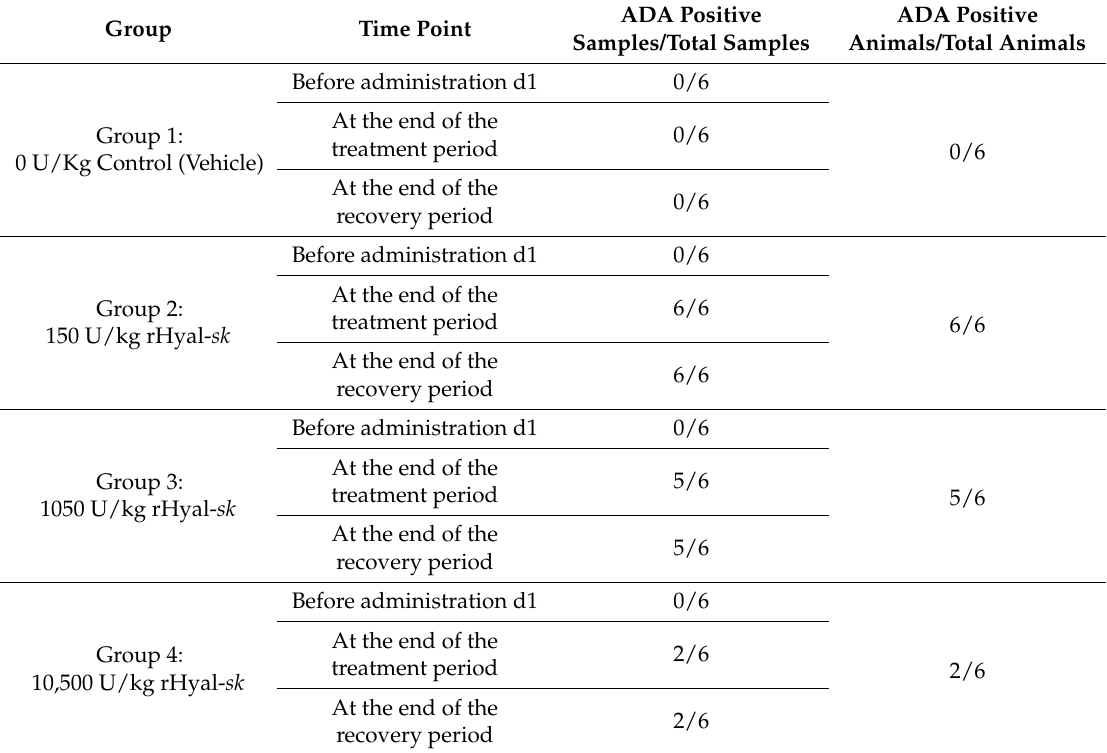
Table 1. ADA induction